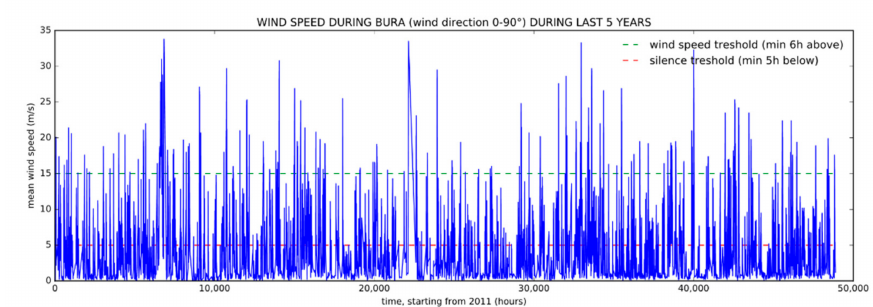
Figure 4. Hourly average wind speed measurements.